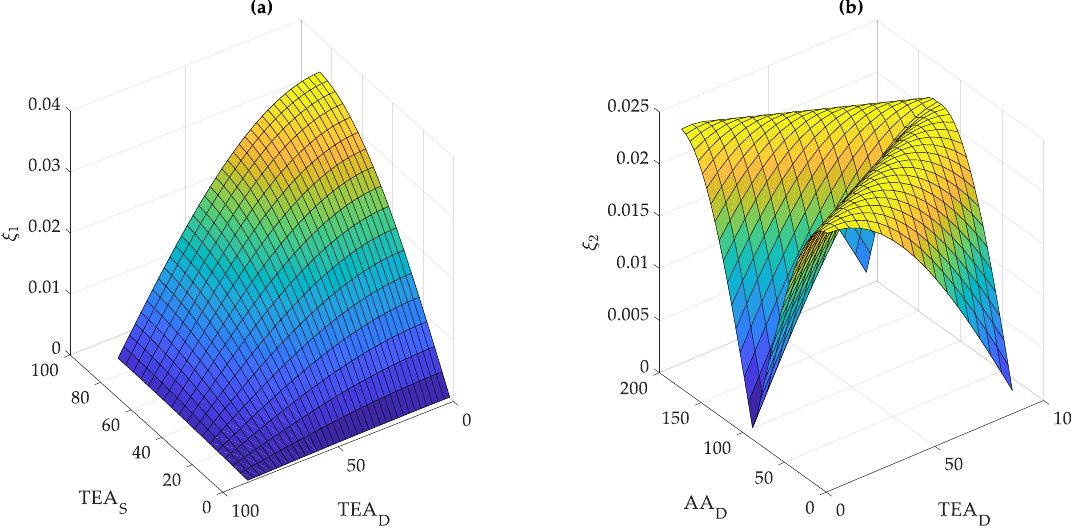
Figure 8 . First term of Equation (16) ( a ), and second term of Equation (16) ( b ) .